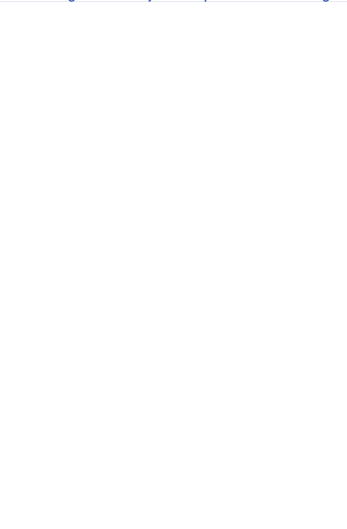
Fig 10. Arm A and Arm B: ART coverage estimates, by trial arm, sex, country, and round (with extrapolation to the total population). ART, antiretroviral therapy; R1, Round 1; R2, Round 2; R3, Round 3.